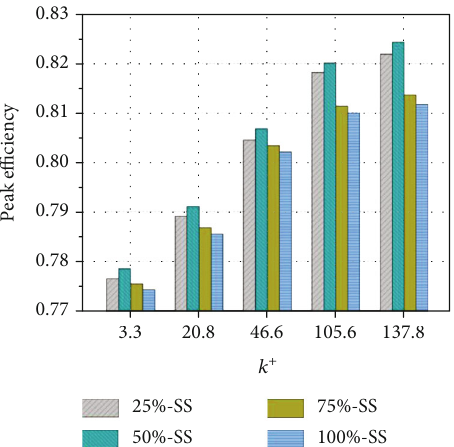
Figure 19: The variation in the peak e ffi ciency with di ff erent surface roughness magnitudes and locations.